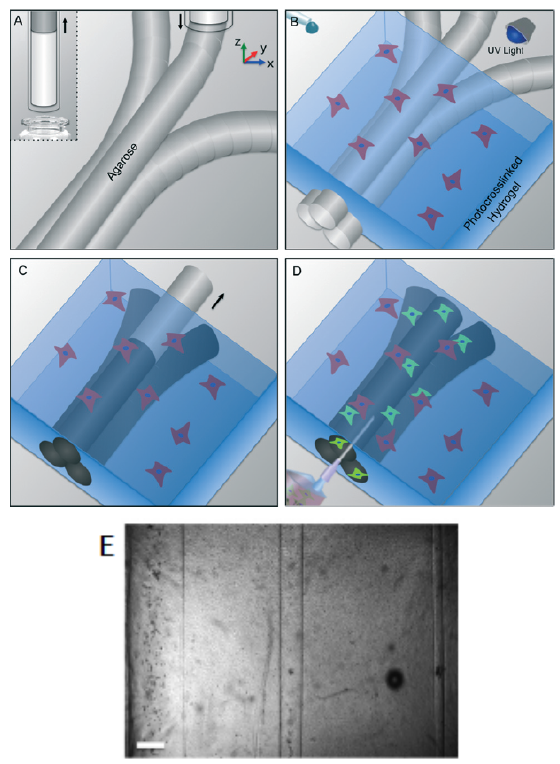
Figure 16. Bioprinting of agarose template fibres and microchannels fabrication with template micromoulding. ( a ) The agarose is aspirated by a bioprinter. After a 4 ◦ C thermal stage, agarose fibers are bioprinted at predefined locations; ( b ) A hydrogel precursor is casted over the bioprinted mould and photocrosslinked; ( c ) The template is removed from the surrounding photocrosslinked gel; ( d ) Formation of fully perfusable microchannels ( e ) microchannels representation (from left to right: 1000 µ m, 500 µ m, and 150 µ m diameter, 500 µ m scale bar). (Reproduced with permission from [44].)